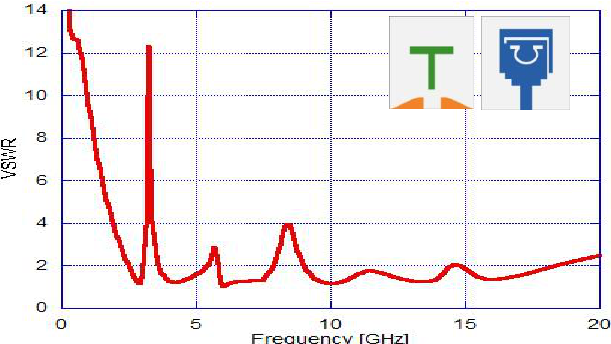
Figure 8: Simulated VSWR for the proposed triple band notched antenna.